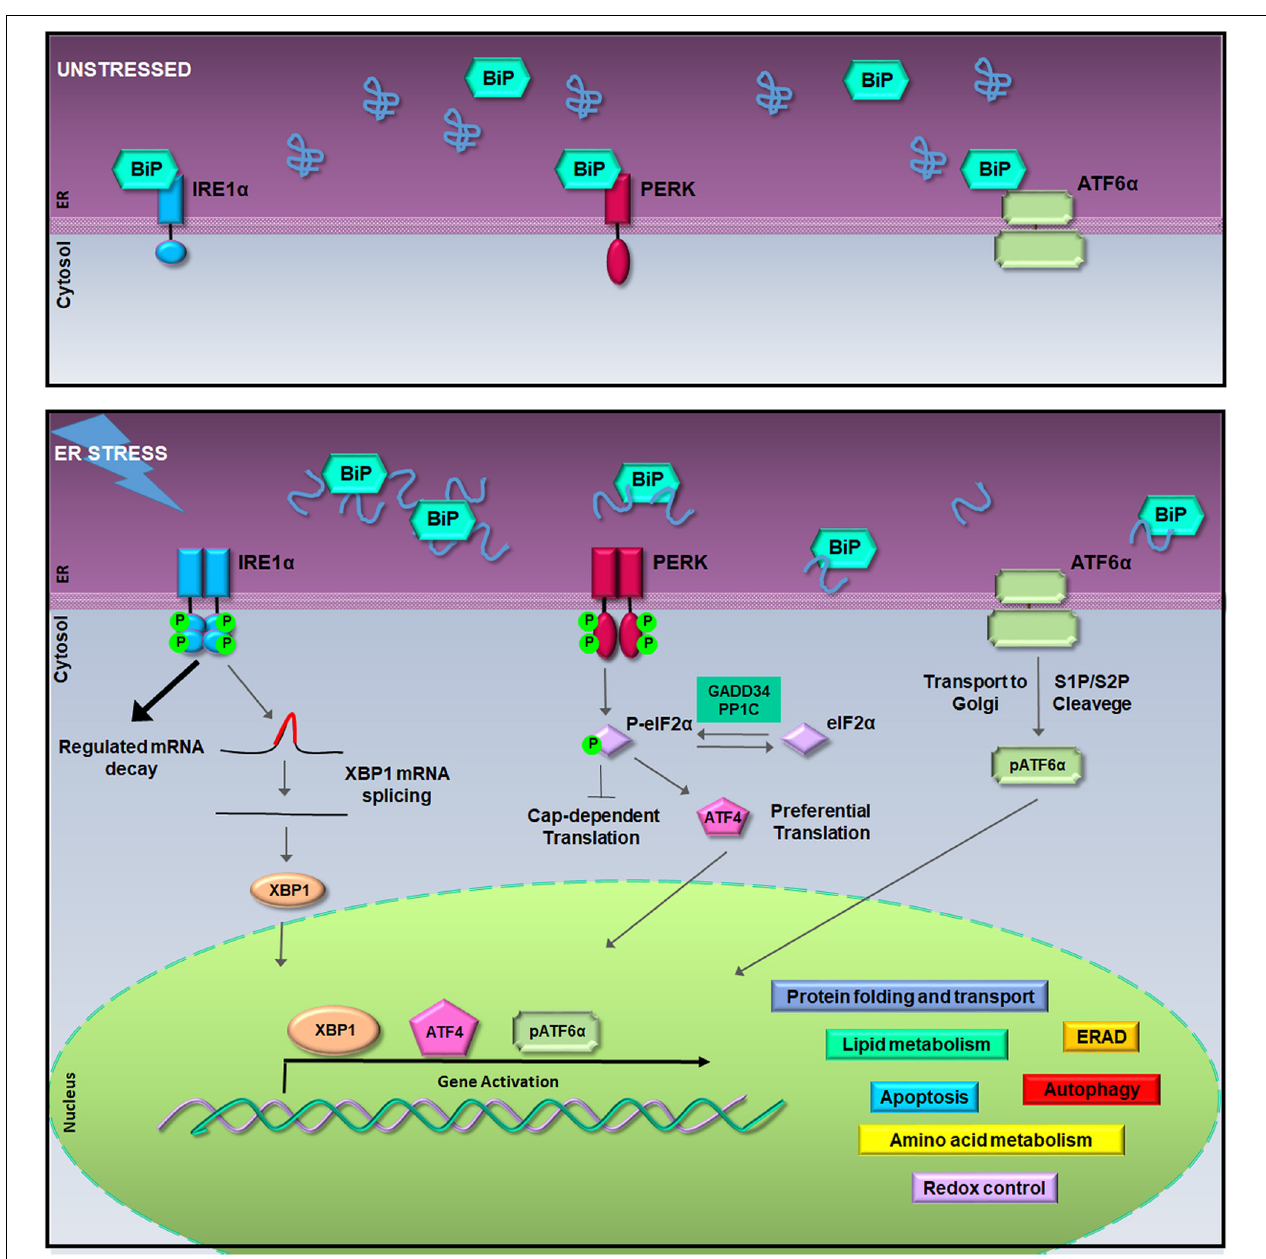
FIGURE 1 | The unfolded protein response (UPR) signaling pathway. In unstressed conditions (upper box), the activation of inositol-requiring enzyme 1a (IRE1 α ), pancreatic ER kinase (PERK), and activating transcription factor 6a (ATF6 α ) is inhibited by the binding of Bip/GRP78. During the endoplasmic reticulum (ER) stress, binding of glucose regulated protein 78-kDa/binding immunoglobulin protein (GRP78/BiP) to misfolded proteins allows the activation of IRE1 α , PERK, and ATF6 α (lower box). Activated IRE1 α cleaves 26-nucleotides from the X-box binding protein 1 (XBP1) mRNA allowing the translation of XBP1; hyper-oligomerized IRE1 α executes regulated IRE1a-dependent decay (RIDD) activity on selected cytosolic mRNAs (Cox and Walter, 1996; Hollien et al., 2009). Activated PERK phosphorylates the eukaryotic initiation factor 2a (eIF2 α ) leading to attenuation of protein synthesis and to the preferential translation of activating transcription factor 4 (ATF4) mRNA (Harding et al., 2000). ATF6 α activation is achieved in the Golgi complex where it undergoes to intramembrane proteolysis-specific cleavage by site-1 protease (S1P) and S2P to produce a transcriptionally active fragment (pATF6 α ). XBP1, ATF4, and pATF6 α are responsible for the execution of the UPR transcriptional program in the nucleus (Walter and Ron,